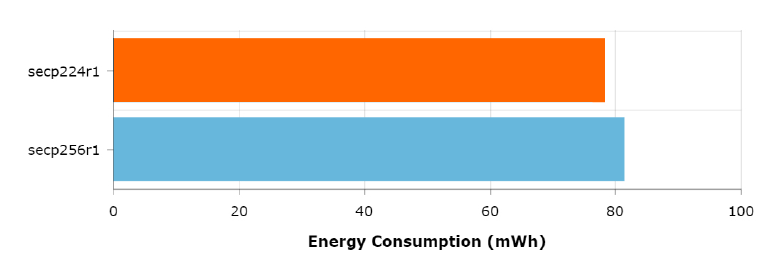
Figure 6. Energy consumption of secp224r1 and secp256r1 curves without NIST modulo p optimizations